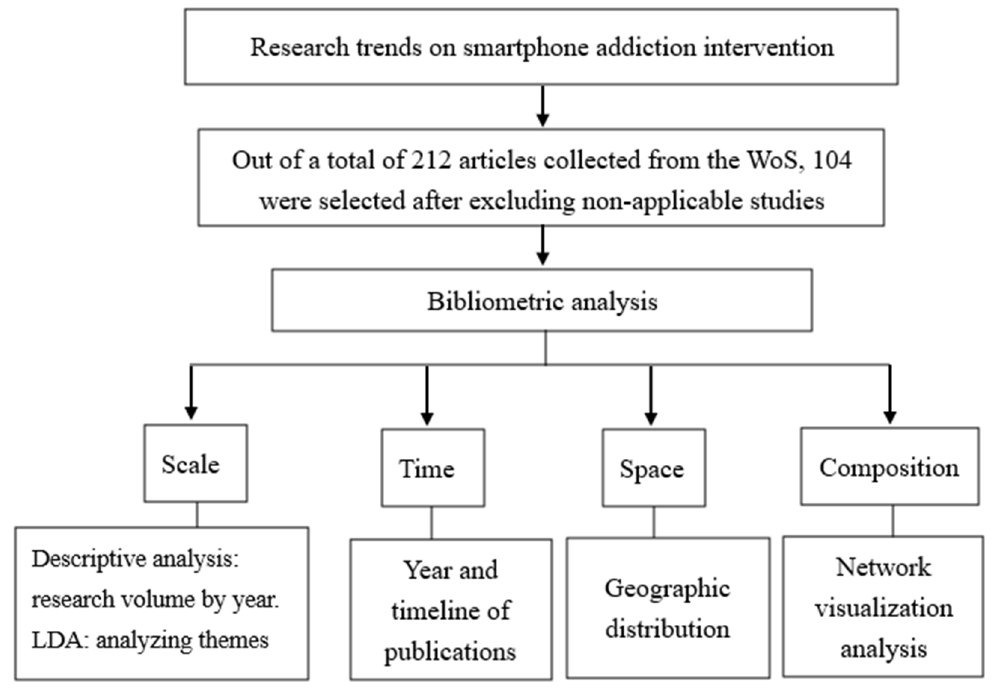
Figure 2. Research Figure 2. Research framework.